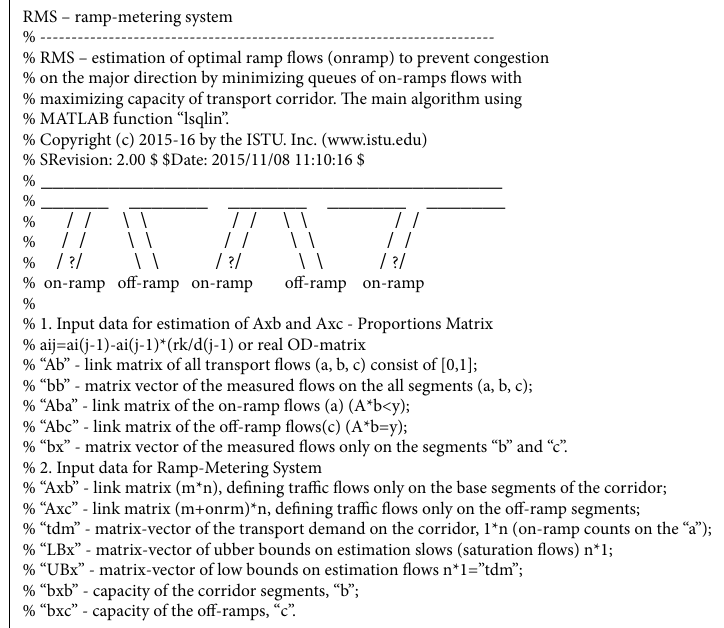
Fig. 5. MATLAB code listing for proposing the RM